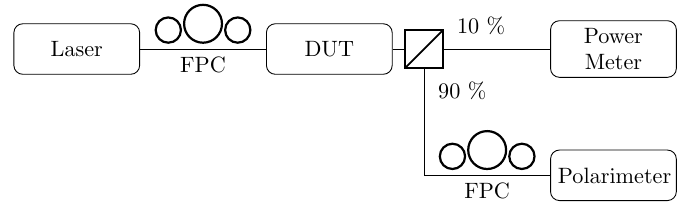
Figure 20. Setup used for the characterisation of the controller configuration. FPC, fibre polarisation controller; DUT, device under